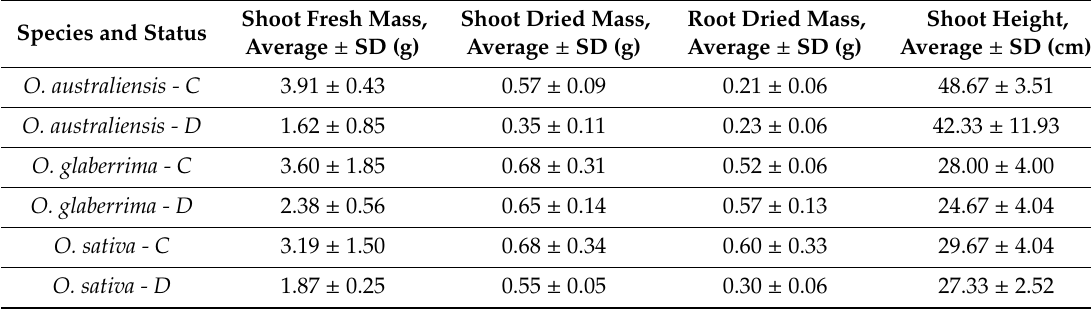
Table 1. Summary of seedling height and mass data collected for three species of rice.